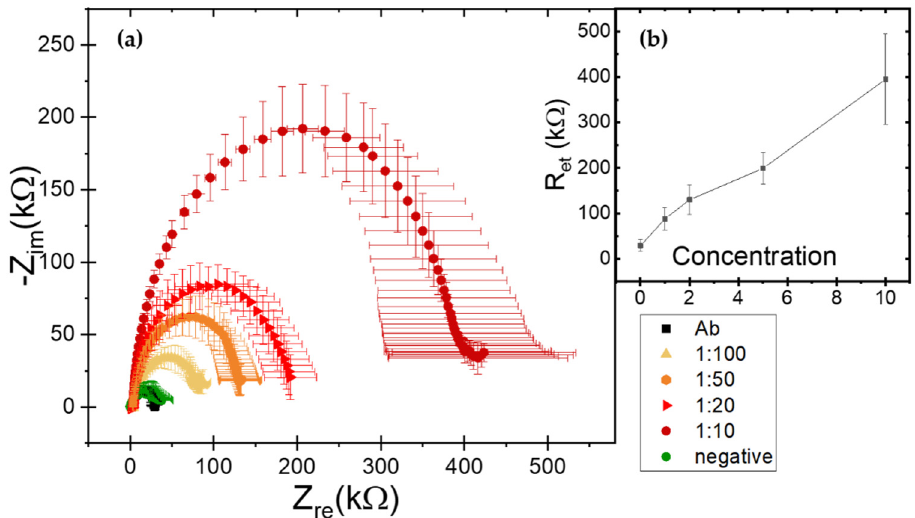
Figure 3. ( a ) Nyquist spectra in response to serial dilutions of GLRaV-3 virus source homogenate. Black curve is related to antibody functionalization. Negative sample response corresponds to green curve. Incubation with positive samples leads to higher impedance values, from 1:100 (yellow curve) to 1:10 (red curve) with an increased darkness in the curve color ( b ) Biosensor calibration curves for GLRaV-3 in terms of R et (mean ± SD) vs. concentration expressed as 100 divided dilution factor. R et was evaluated by means of fits with a simplified Randles equivalent circuit model.